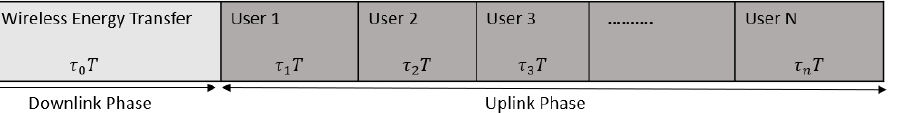
Figure 2. The time division duplex (TDD) frame-based wireless powered communication network (WPCN) scheme: The total TDD frame is divided into two phases. In the downlink phase, the H-AP transmits an arbitrary wireless energy signal to all receivers. The uplink phase shows the allocation of time for each receiver to transmit information to the